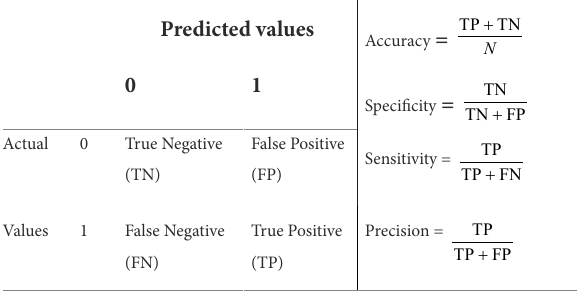
* Table is taken from Eegdeman et al.